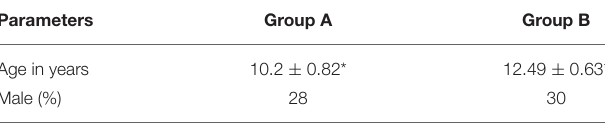
TABLE 2 | Characteristics variables for two groups (* p < 0.05).